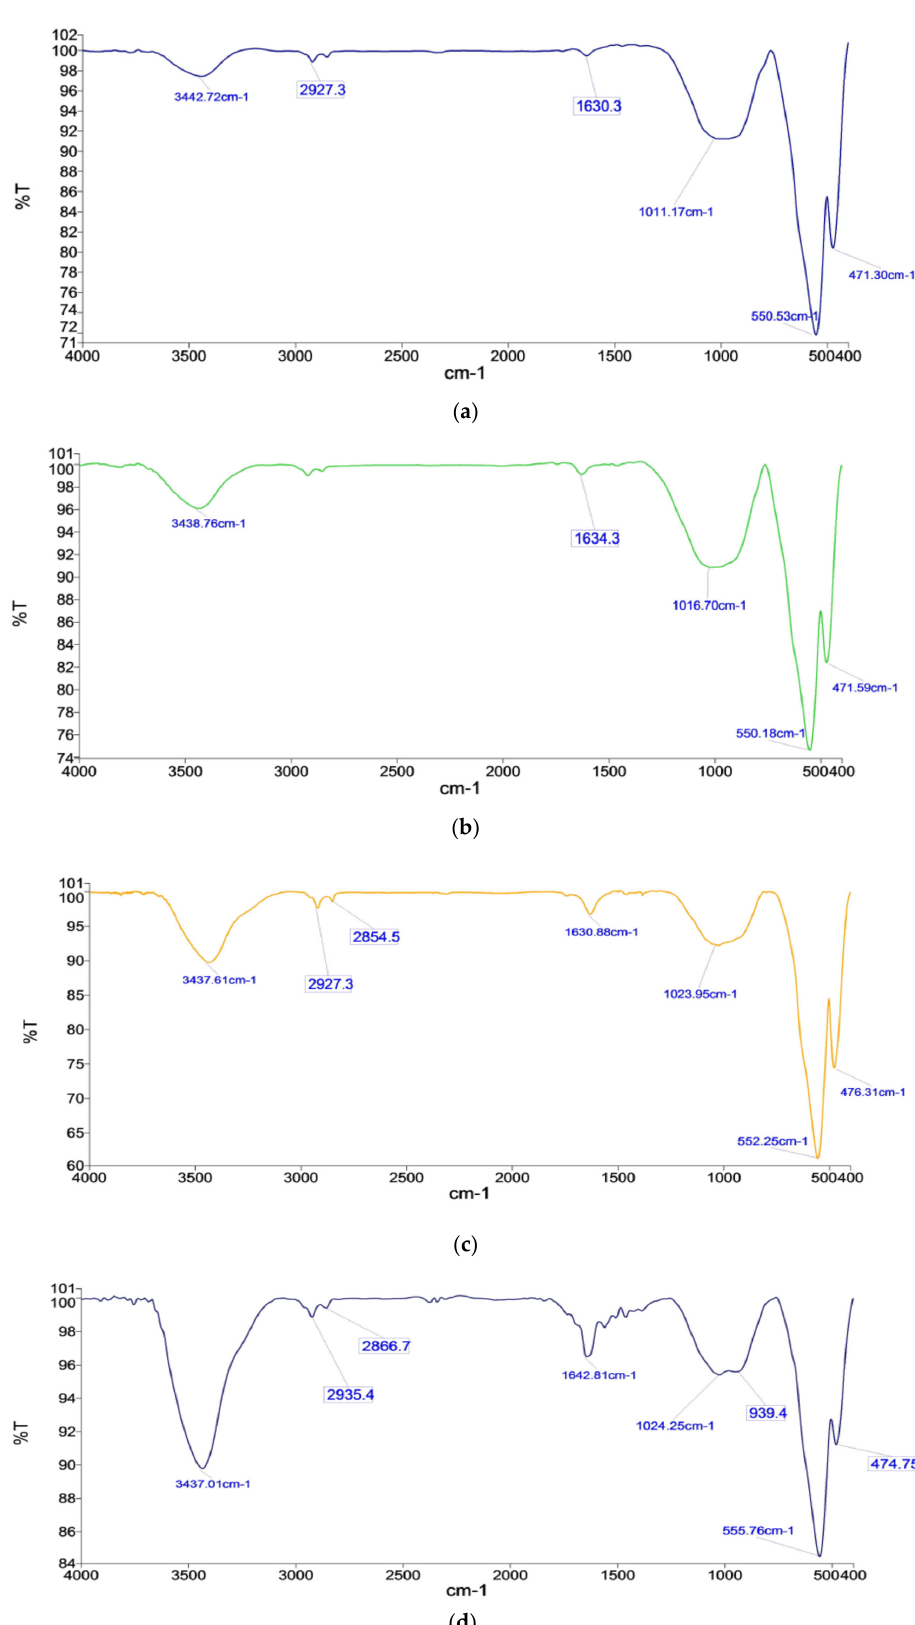
Figure 15. FTIR spectrographs of pellets ( a ) K1A, ( b ) K2B, ( c ) K3A, and ( d ) K4C.